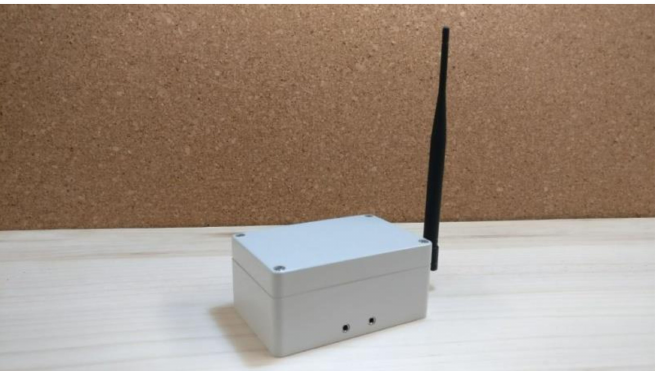
Figure 2. Node sensor (end-device for the lab